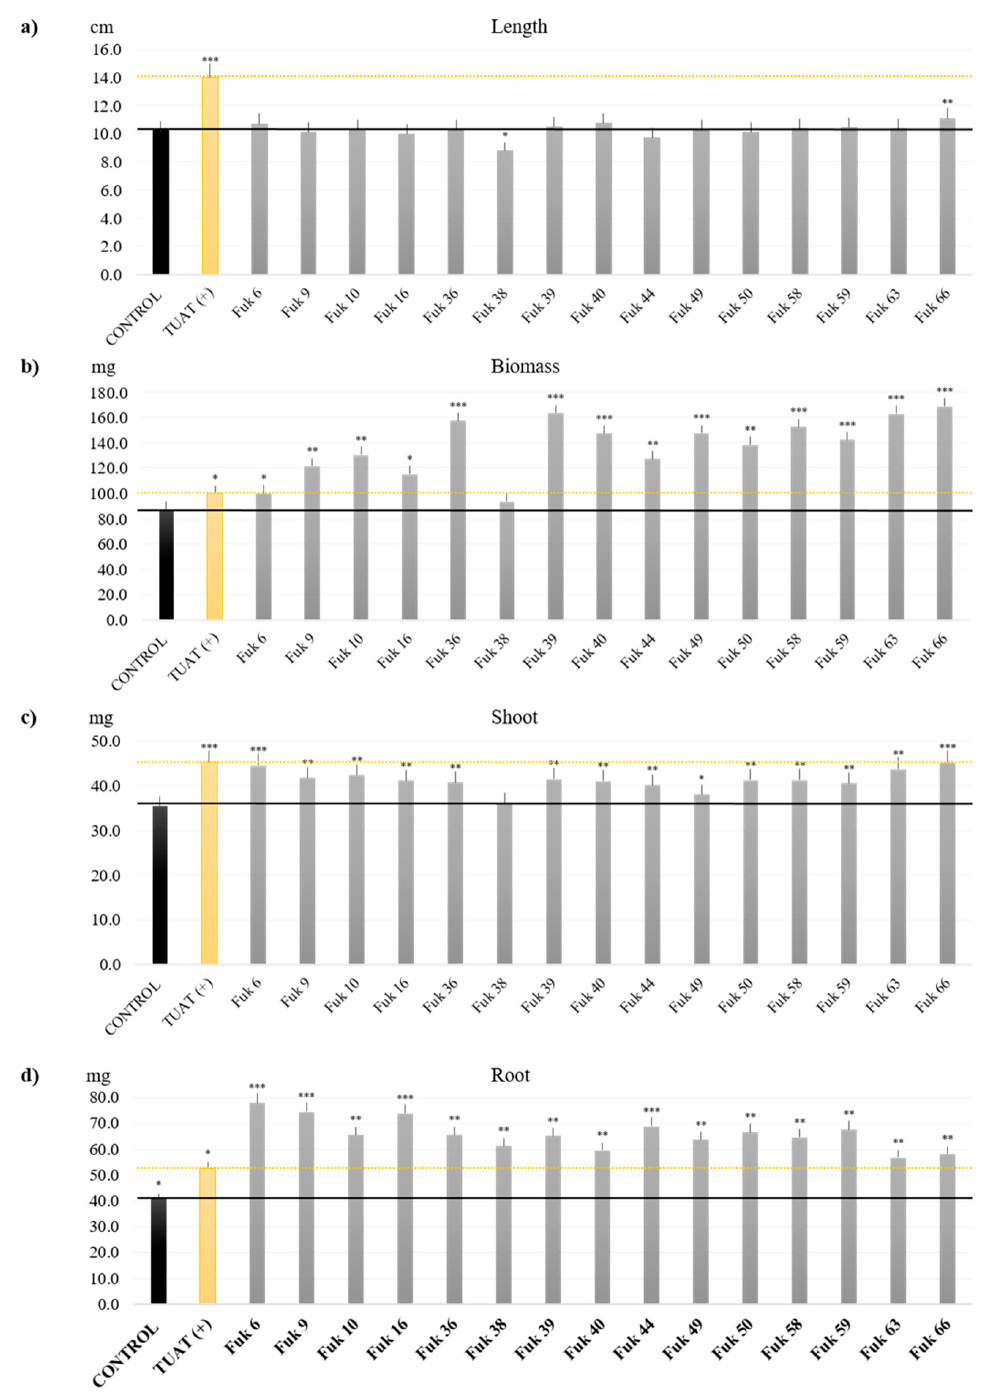
Figure 7. Inoculation of Oryza sativa L. Koshihikai with each pre-selected fungi isolates. The results are based on the total mass and length average from 5 plants with 3 replications for each treatment. ( a ) length (cm), ( b ) total fresh biomass (mg), ( c ) total fresh shoot mass (mg), and ( d ) total root mass (mg). Control means non-inoculation, and TUAT1(+) means positive control from based spore- forming biofertilizer. Dunnet’s test was used for length and control as based comparative,